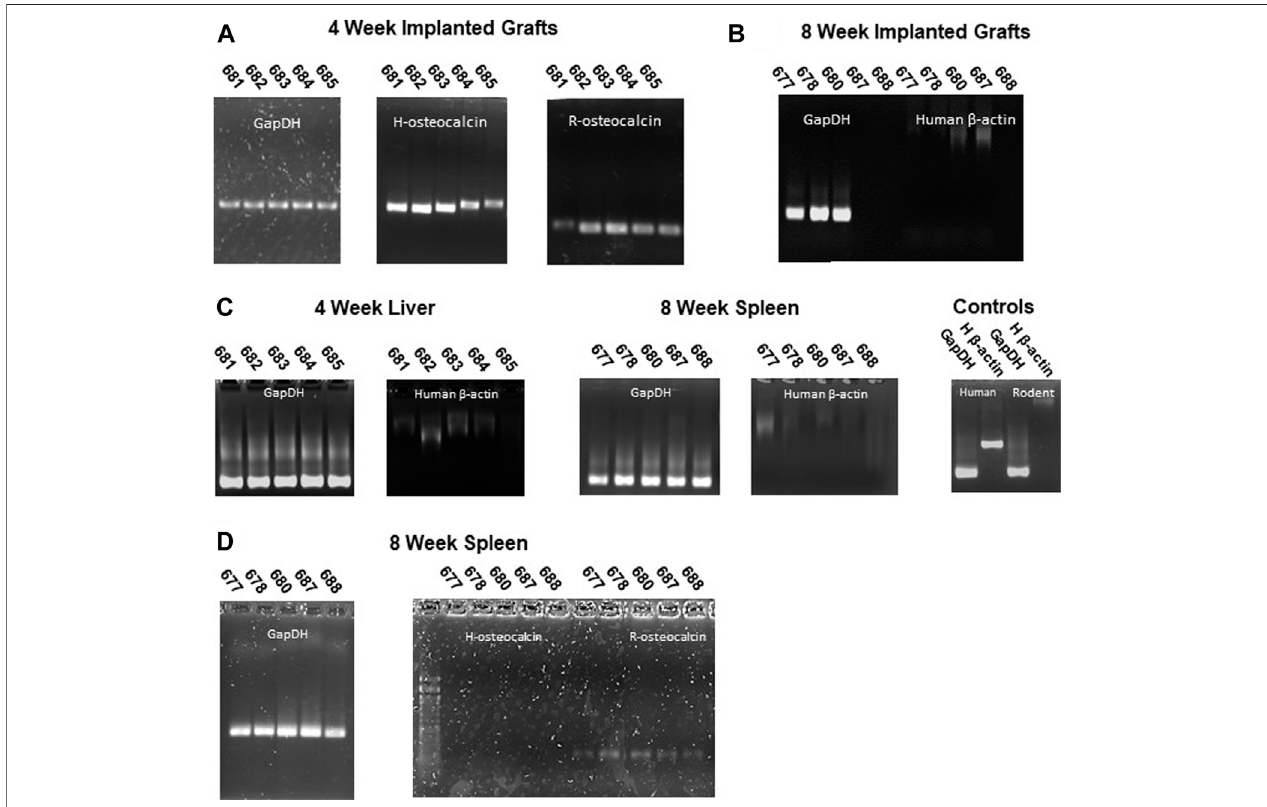
FIGURE6| Humanosteoblastsarepresentingraftsbutnotinperipheraltissues. (A) Humanandratosteocalcintranscripts,markersofosteoblasts,arepresentin 4-week implants. (B) No human cells (absence of human β -actin sequence) were detected in grafts implanted for 8 weeks. (C) Rat, but not human ( β -actin) sequences weredetected inliver(4 weeks) or spleen (8 weeks) genomic DNA. (D) Rat but not human osteocalcin transcriptswere detected inperipheraltissues(spleen) of8-week recipient animals. GAPDH primers were used to con fi rm intact templates for transcript PCR.